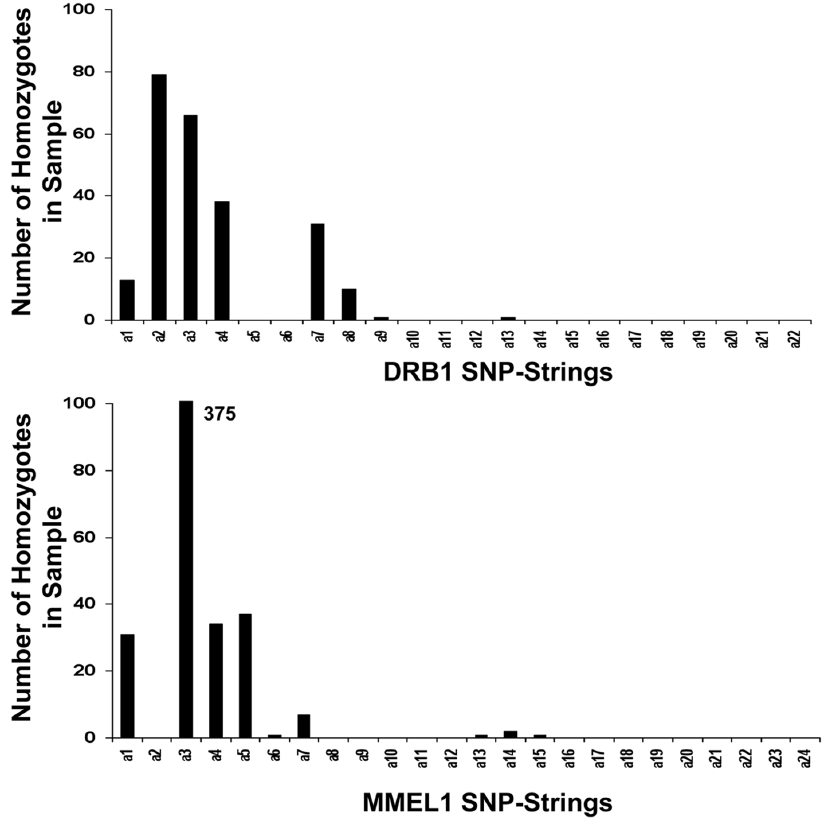
Figure 3. Number of homozygous SNP-strings in the DRB1 and MMEL1 clusters. NB: In the panel depicting the MMEL1 SNP-strings, the number of (a3) homozygotes was 375. The (a3) bar has been cut off at 100 in order to better illustrate the remainder of the distribution.